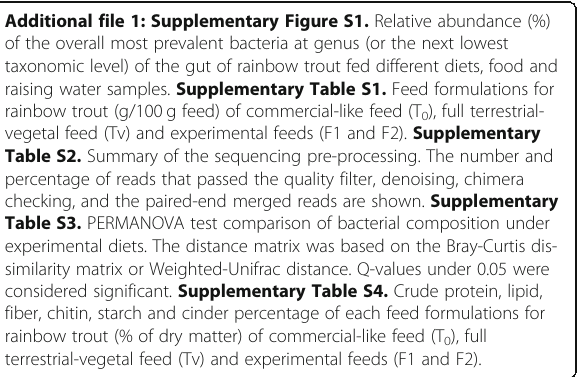
Table S2. Summary of the sequencing pre-processing. The number and percentage of reads that passed the quality filter, denoising, chimera checking, and the paired-end merged reads are shown. Supplementary Table S3. PERMANOVA test comparison of bacterial composition under experimental diets. The distance matrix was based on the Bray-Curtis dis- similarity matrix or Weighted-Unifrac distance. Q-values under 0.05 were considered significant. Supplementary Table S4. Crude protein, lipid, fiber, chitin, starch and cinder percentage of each feed formulations for rainbow trout (% of dry matter) of commercial-like feed (T 0 ), full terrestrial-vegetal feed (Tv) and experimental feeds (F1 and